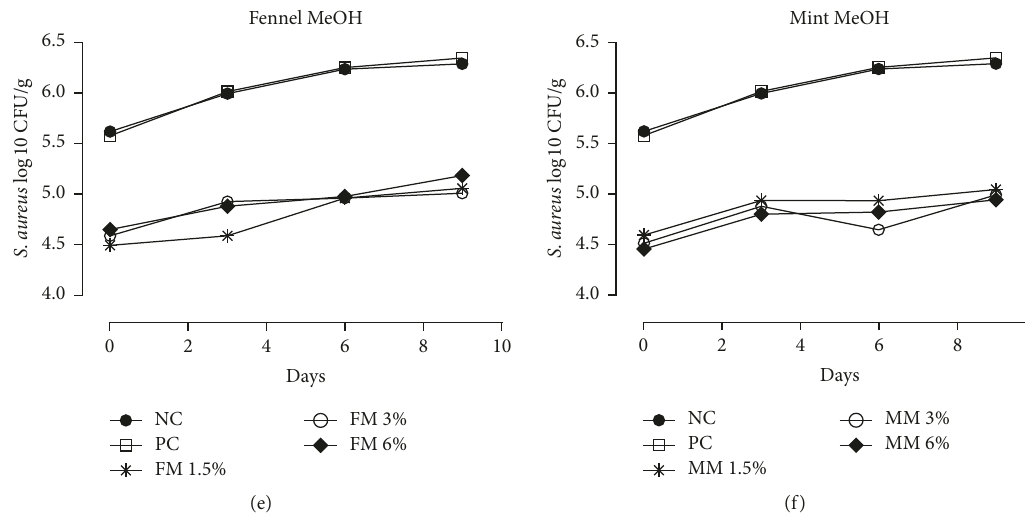
Figure 2: S. aureus inhibitory activity of spice extracts in marinated minced beef under refrigerated (4 ° C) 9 d storage. NC: negative control, PC: positive control, OM: onion methanolic extracts, GM: ginger methanolic extracts, TM: turmeric methanolic extracts, CM: coriander methanolic extracts, FM: fennel methanolic extracts, and MM: mint methanolic